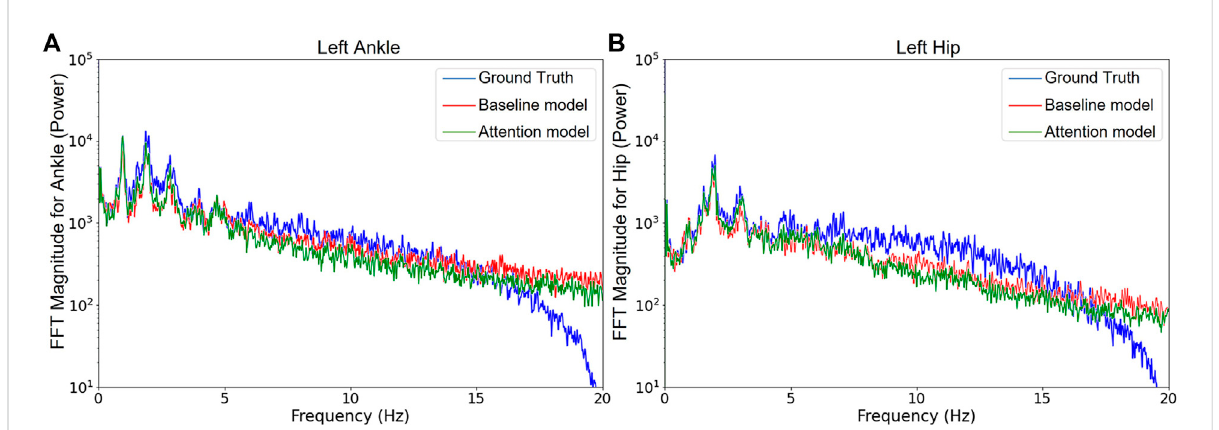
walking and 3) from level-walking to stopped. From Figures